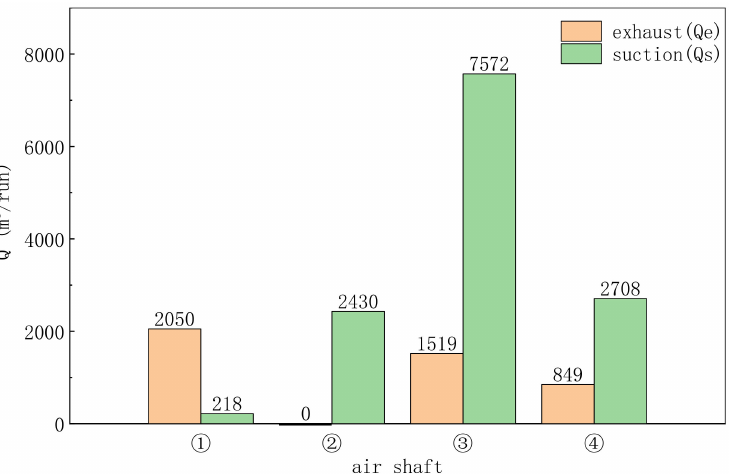
Figure 10. Average effective exhaust/suction air volume of different air